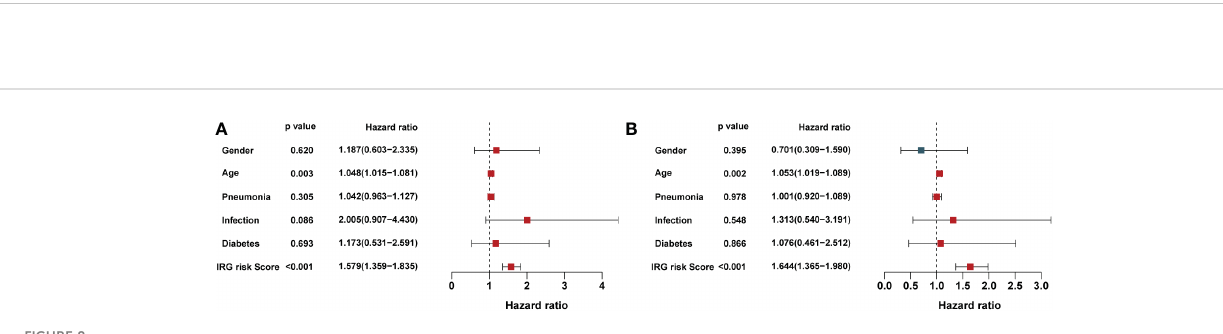
FIGURE 8 Univariate and multivariate analysis of the in fl uence of speci fi c clinical characteristics on the outcome of sepsis: (A) Univariate analysis and (B) multivariate